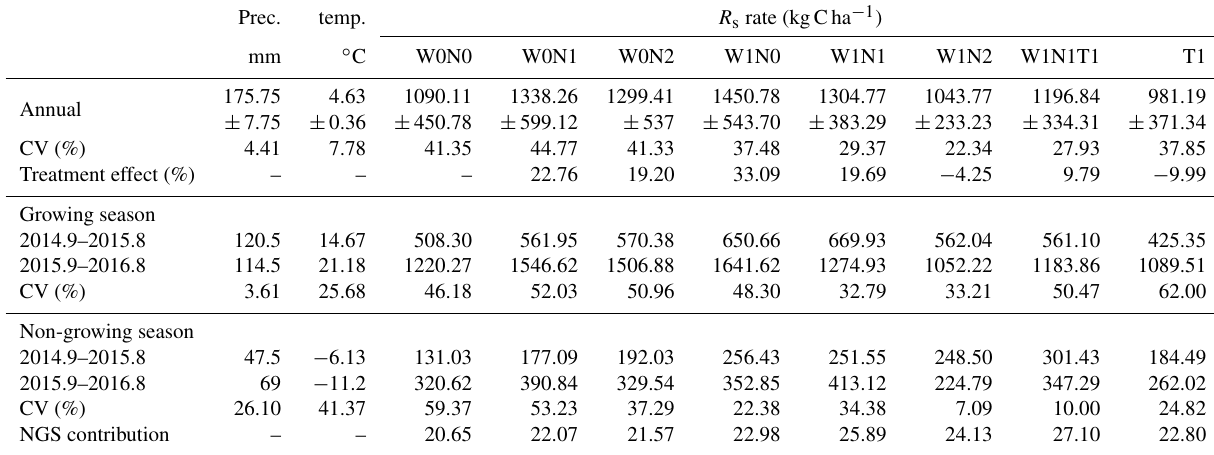
Table 1. The annual, growing season (GS), non-growing season (NGS) and between-year fluxes and variation of soil respiration ( R s ) over September 2014 to September 2016 (mean ± SE), including the contribution of GS and NGS, and the treatment effect. The positive values stand for increased R s , and the negative value stand for reduced R s . Dates are shown in YYYY.M format. Prec.